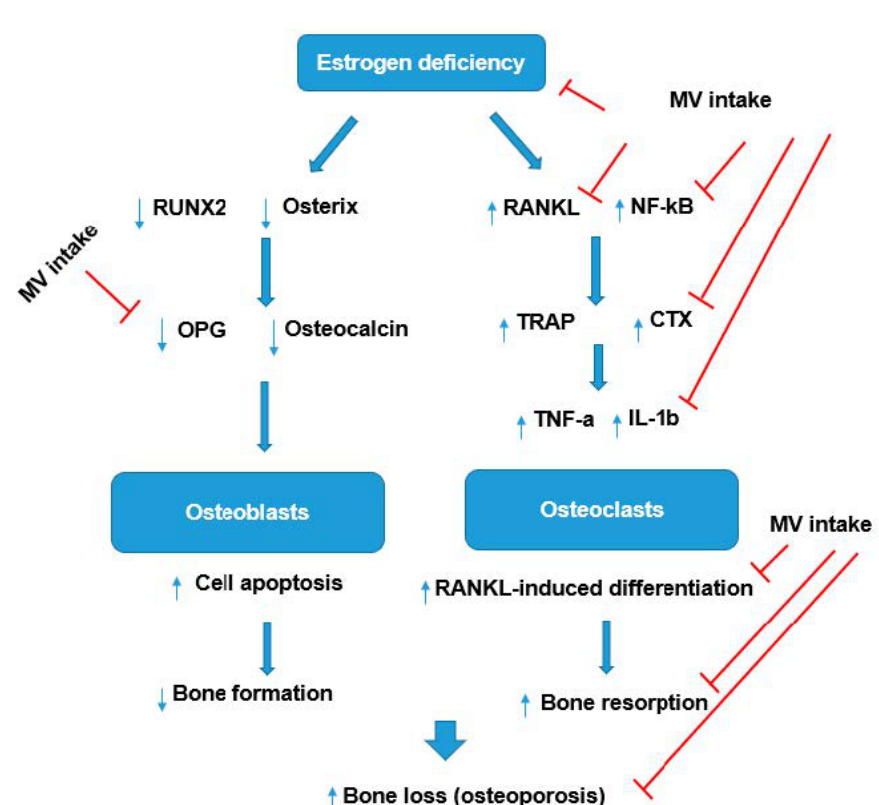
Figure 6. The potential mechanism of mulberry vinegar (MV) intake to protect against bone loss (osteoporosis) in an estrogen-deficient state. Estrogen deficiency decreased RUNX2 and osterix signaling pathways to inhibit OPG and osteocalcin production, which stimulates osteoblast apoptosis to reduce bone formation. Estrogen deficiency increases RANKL production to activate RANKL and NF- κ B signaling pathways. It increased TRAP and CTX-1 production and stimulated the production of proinflammatory cytokines to activate osteoclast differentiation. As a result, estrogen deficiency promotes bone loss. MV intake mainly inhibited osteoclast differentiation by suppressing the RANKL-related inflammation signal pathway and partially increasing estrogen production.